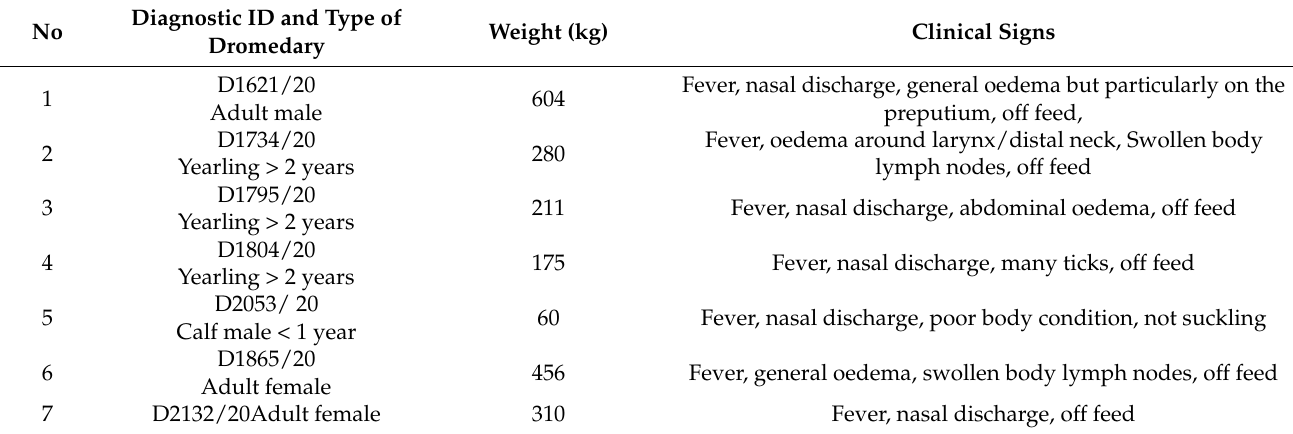
Table 2. Clinical signs of dromedaries suffering from camelpox recorded seven days before their